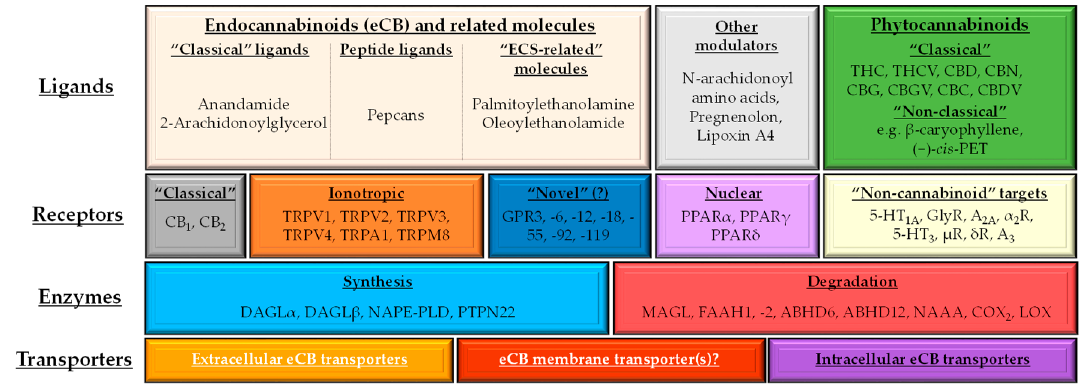
Figure 1. Schematic overview of the (endo)cannabinoid system (ECS) and its putative connections to other signaling systems. Depending on how we choose to limit the definition, the number of the putative ligands as well as that of the possible targets increases dramatically; therefore, on the figure, we only summarize the most important ones. Each ligand possesses a unique molecular fingerprint, i.e., the ability to concentration-dependently activate/antagonize/inhibit a selected group of possible targets. Obviously, all these actions are highly context-dependent (e.g., they are influenced by the relative expression of the potential targets in the given tissue, the concentration of the substance), resulting in characteristic, and in some cases even opposing biological responses. Although the classical, lipophilic eCBs definitely require inter- and intracellular carriers, relatively little is known about these transporter systems. Intracellular eCB transporters may include fatty acid binding proteins (FABPs) and heat shock protein 70 (HSP70), whereas FABP4, albumins, HSP70 and extracellular vesicles [61,62] are likely to be involved in their intercellular transport [63]. With respect to FAAH1 and -2 it is important to note that only scarce evidence is available about the expression and functionality of the latter. Intriguingly, FAAH2 is not expressed in mice and rats, but shares substrate spectrum of FAAH1 (however, it has inferior affinity towards AEA and N-acyl taurines). Conventional FAAH-inhibitors can inhibit its activity [48], and its missense polymorphism (A458S) may lead to psychiatric disorders (anxiety, mild learning disability) [64]. Later in the text, except when stated otherwise, by mentioning “FAAH”, we refer to “FAAH1”. 5-HT: 5-hydroxytryptamine (serotonin) receptor; A 2A and A 3 : adenosine 2A and 3 receptors; ABDH6 and -12: α / β -hydrolase domain containing 6 and 12; CBC: ( − )-cannabichromene; CBD: ( − )-cannabidiol; CBDV: ( − )-